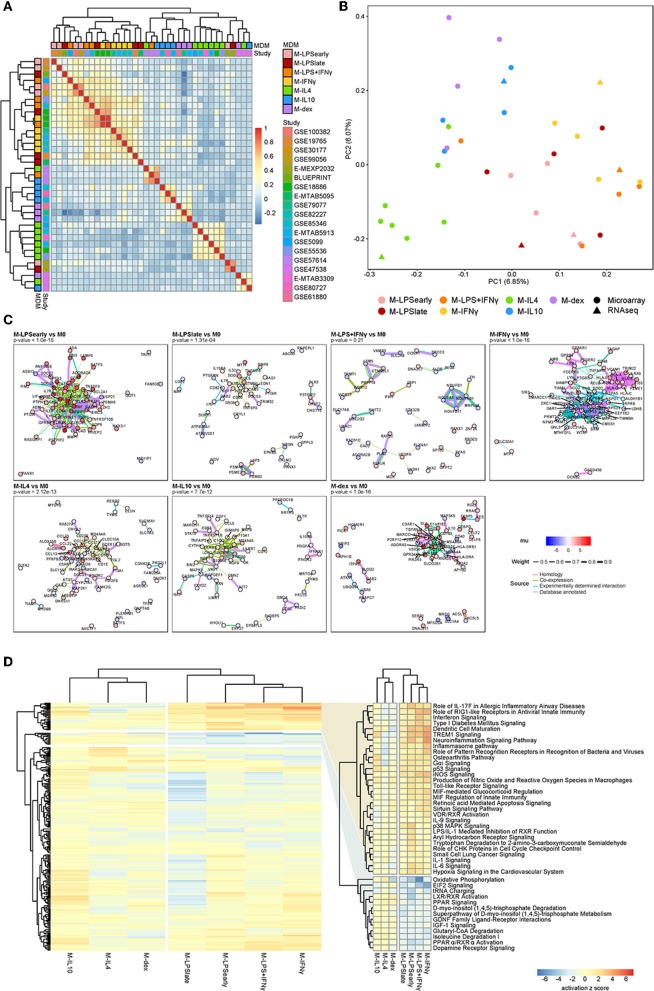
Summary meta-analysis. (A) Heatmap of the Cohen d pairwise Spearman correlation coefficients. (B) Principal component analysis of the Z-values obtained from the meta-analysis. (C) Protein-protein association network as obtained from the top 100 cDEGs using the STRING database. Node colors represent the unbiased estimator of the effect size (mu), whereas the edge colors and thickness represent the source of the cataloged association and the weight of the evidence. (D) Heatmap of the canonical pathways with the intensity representing the activation z score. Two most defining clusters have been enlarged and annotated on the right.